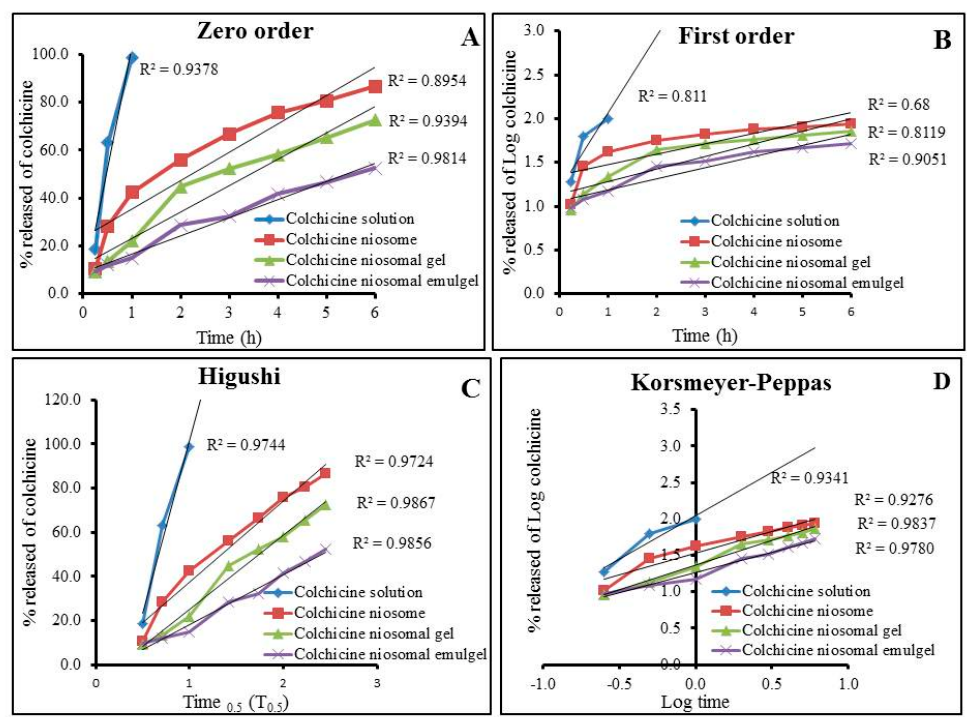
Figure 11. Percentage of drug released from developed Colchicine niosomal formulations against colchicine solution and their kinetic analysis according to ( A ) zero order, ( B ) first order, ( C ) Higauchi, and ( D ) Korsmeyer ‐ Peppas model.